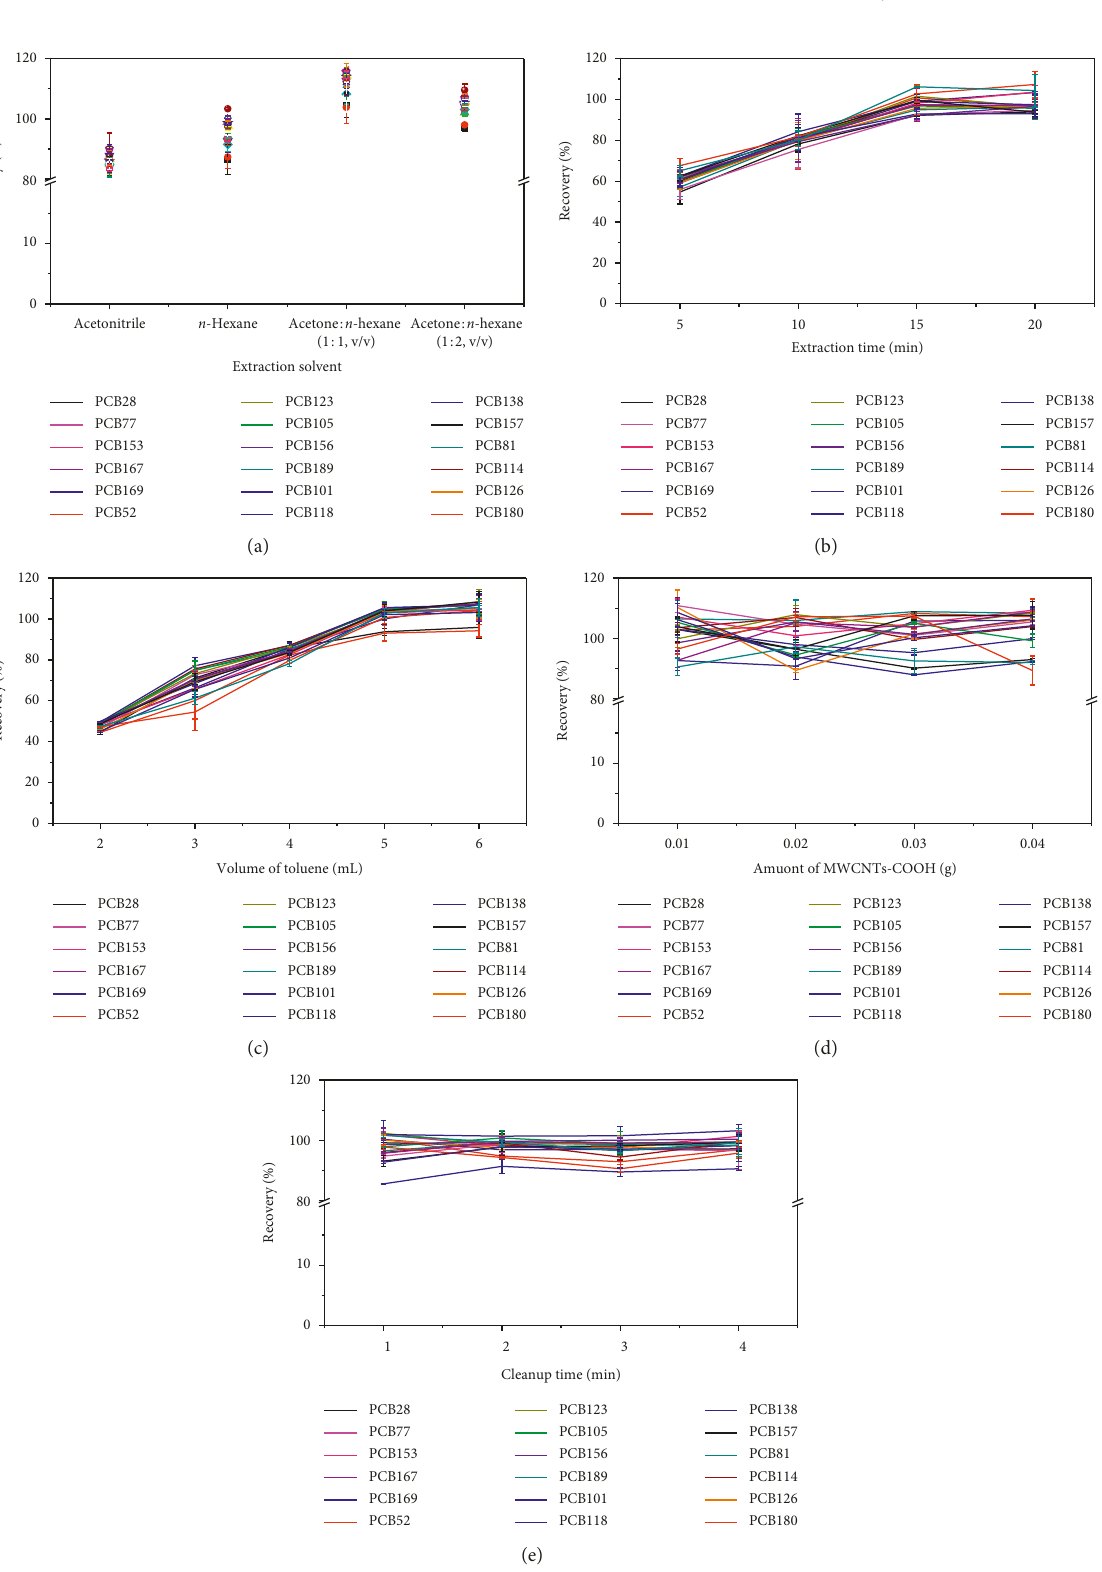
Figure 2: Optimization of major factors affecting extraction and cleanup efficiency ( n � 3): (a) extraction solvent; (b) extraction time; (c) volume of toluene; (d) amount of MWCNTs-COOH; (e) cleanup